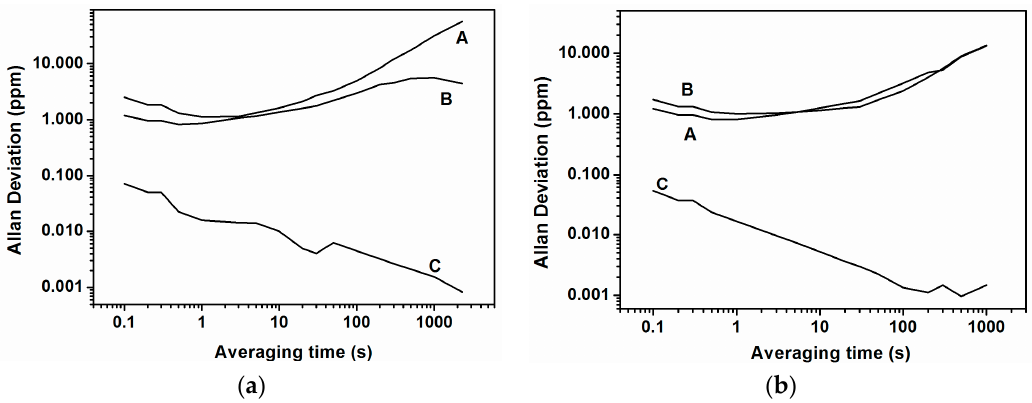
Figure 8. ( a ) Allan deviation in ppm stimulating the cantilever number 2, taking measures every 0.1 s and for stimulus frequencies of: A , at 1.06 MHz; B , at 1.04 MHz; C , at 1.0549 MHz; ( b ) Allan deviation in ppm stimulating the cantilever number 4, taking measures every 0.1 s and for stimulus frequencies of: A , at 1.06 MHz; B , at 1.08 MHz; C , at 1.07348 MHz.